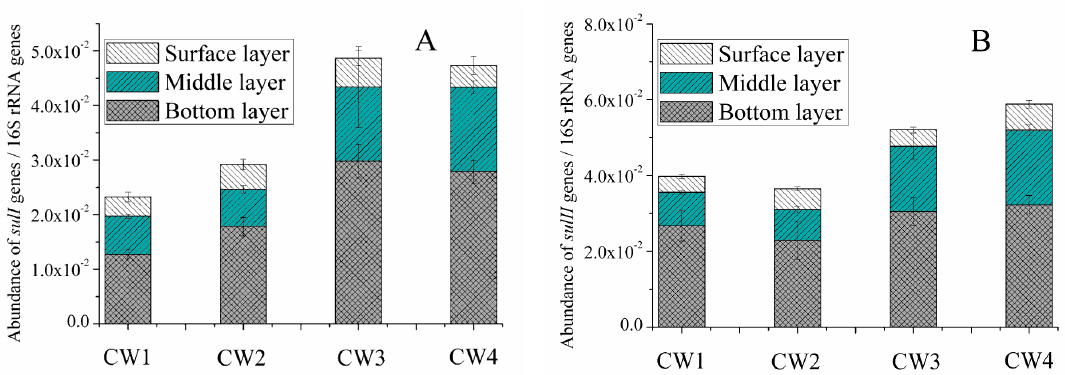
Figure 3. Sul genes ( sulI and sulII ) normalized to 16S rRNA genes in the layers (bottom layer, middle layer and surface layer) of CW1, CW2, CW3, and CW4, respectively (mean ± SD, n = 3). ( A ) sulI genes; ( B ) sulII genes.